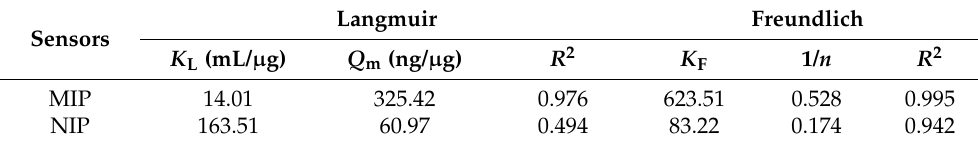
Table 2. Adsorption isotherm parameters of Langmuir and Freundlich models in the MIP/NIP films. Sensors